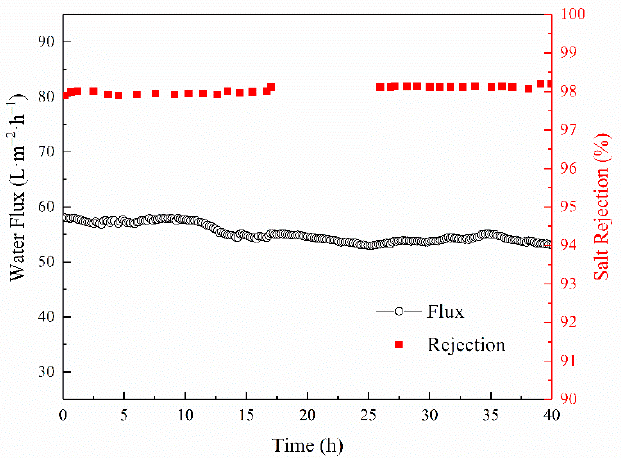
Figure 9. Operational stability of D2/T4-PhA.